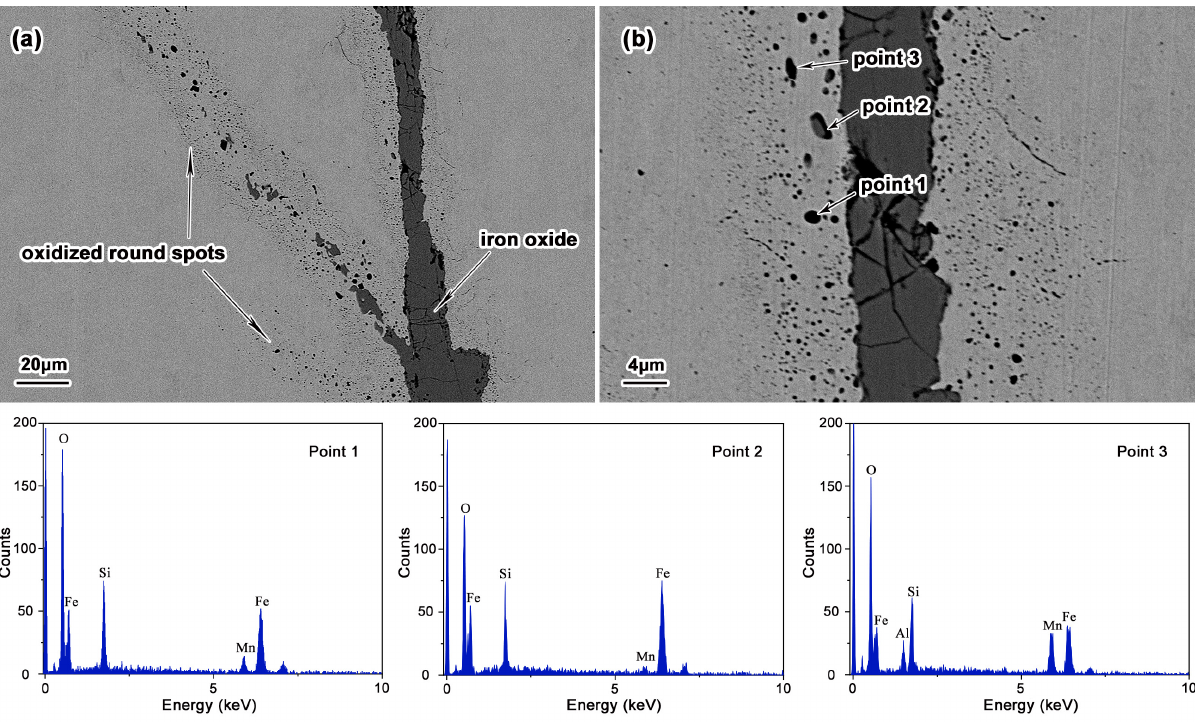
Figure 5: Microscopic morphology (a) and energy spectrum analysis (b) of the oxidized round spots in the reticular crack zone.